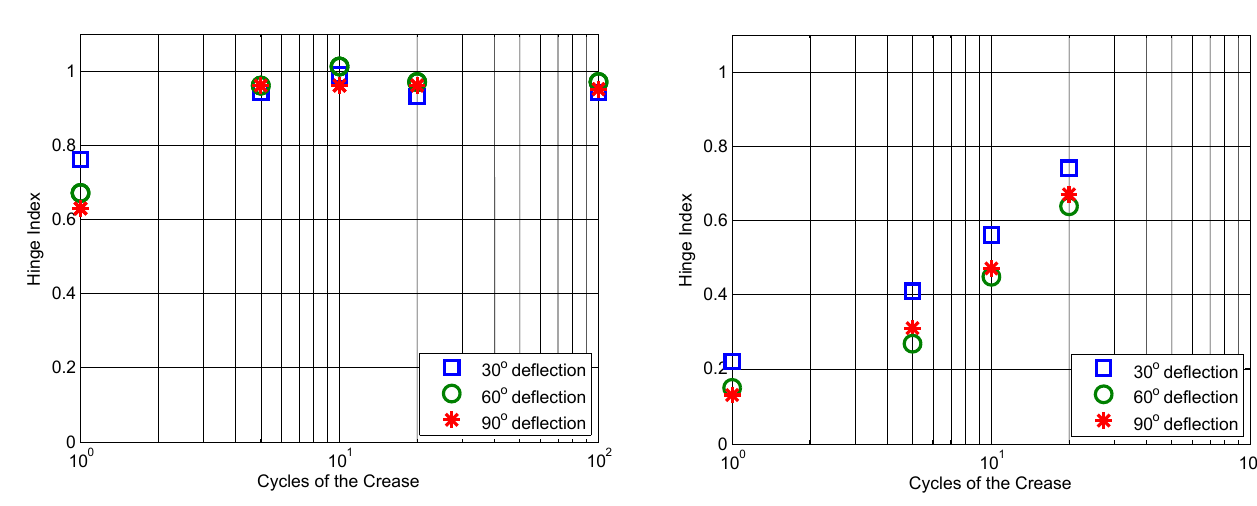
Figure 11. ABS (0.25mm thick): hinge index verses cycles of the crease. The ABS sample fractured before 100 cycles were reached.